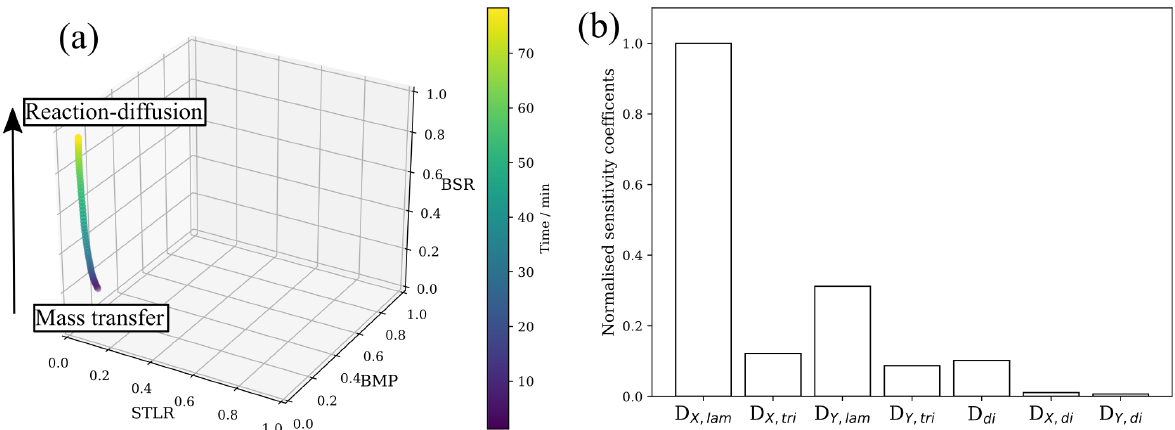
Figure 6. (a) A “kinetic cube” plot (described by Berkemeier et al., 2013) of surface-to-total-loss ratio (STLR), bulk mixing parameter (BMP) and bulk saturation ratio (BSR) for a model run at 77ppm ozone and 0.98µm film thickness. The black arrow illustrates the movement from the mass transfer to the reaction–diffusion kinetic regimes described by Berkemeier et al. (2013). (b) A summary of the normalised sensitivity coefficients for each varied model parameter.